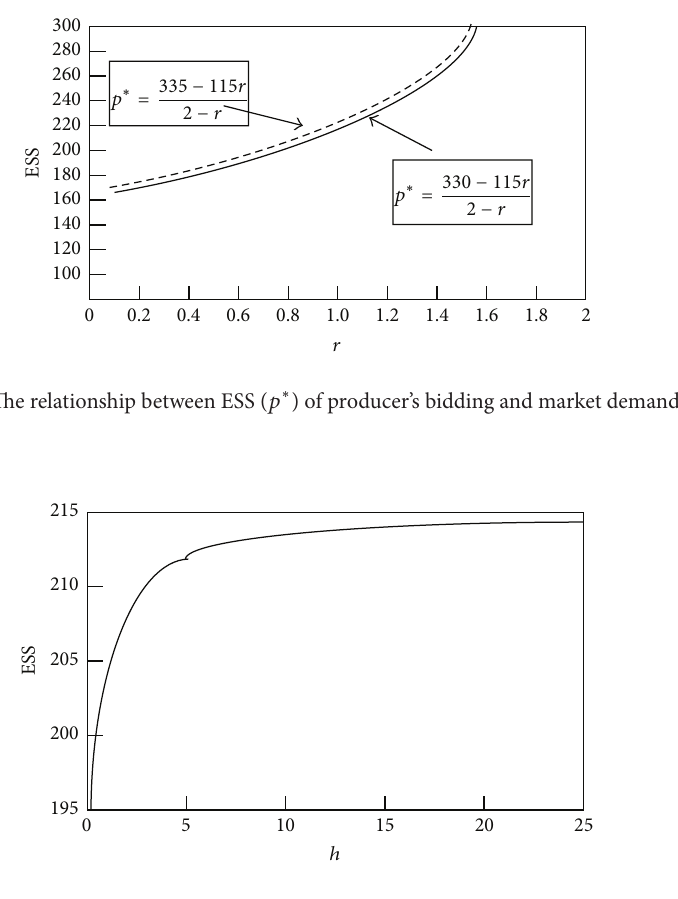
Figure 3: The relationship between ESS of producer’s bidding and bidding frequency ( ℎ ).